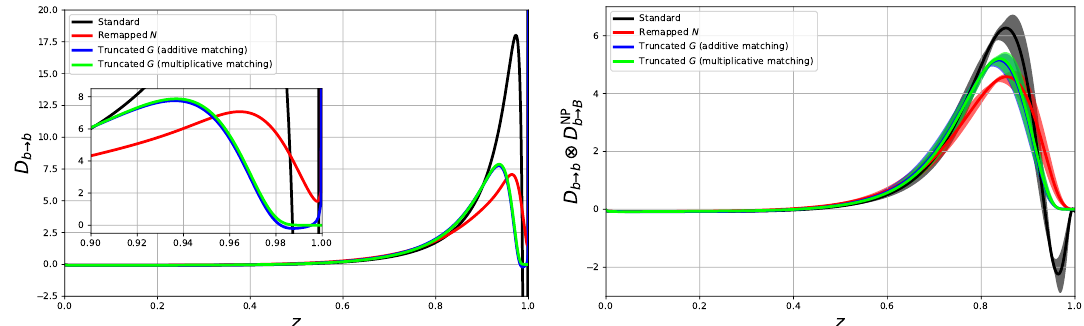
Figure 2 . Different ways for dealing with the Landau pole in the soft gluon resummed PFF. All curves are at NNLO+NNLL for µ = µ = m . Shown are both the PFFs (left) and their Fr, 0 R, 0 b convolution with a fixed NPFF eq. (2.30) (right). The various curves are: the PFF without any regularization of the Landau pole (black), with N remapped (red) and the PFF with a truncated exponent matched to the fixed-order result additively (blue) and multiplicatively (green). The coloured bands in the plot on the right correspond to the uncertainty on the NPFF as shown in eq.